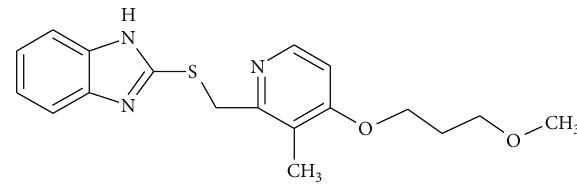
Figure 1: The chemical structure of